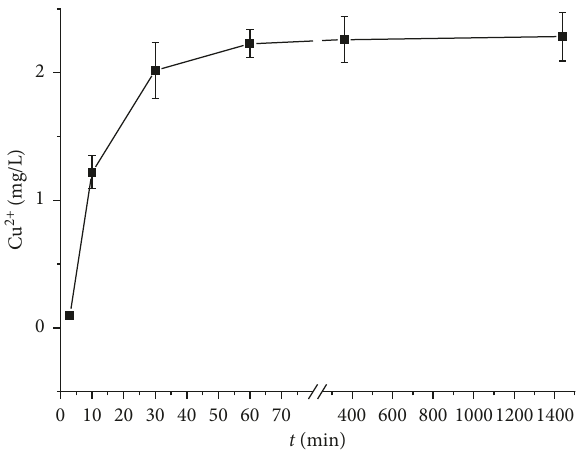
Figure 6: Time-dependent solubility of